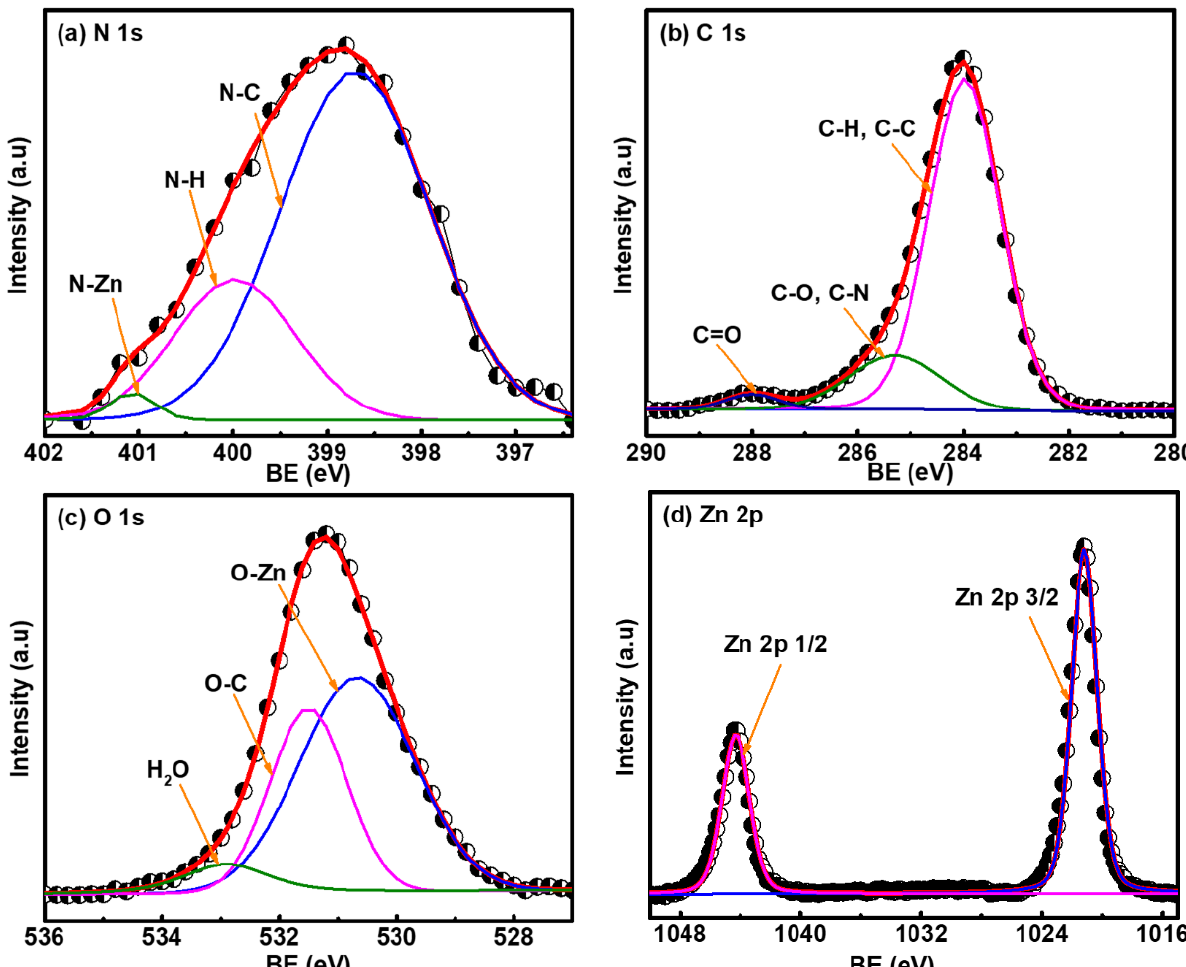
Figure 4. XPS of ( a ) N 1s ( b ) C 1s ( c ) O 1s, and ( d ) Zn 2p of ZIF-8 NPs.